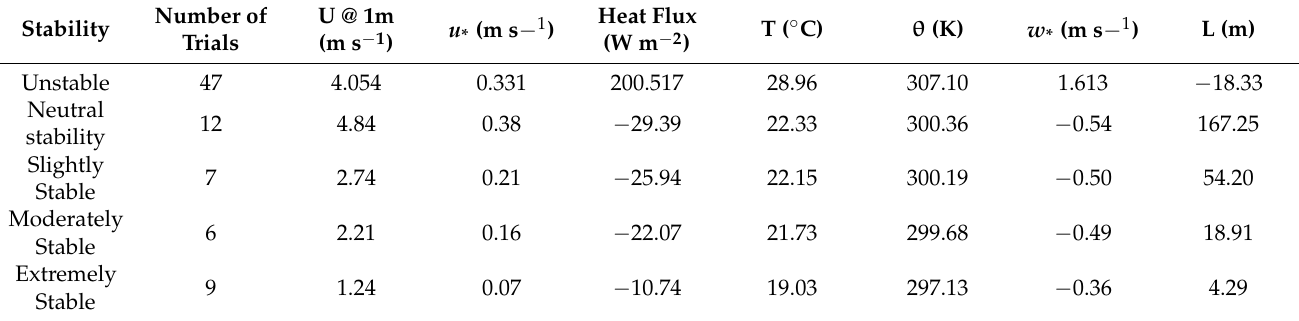
Table 2. The mean environmental conditions of the observational data used in the